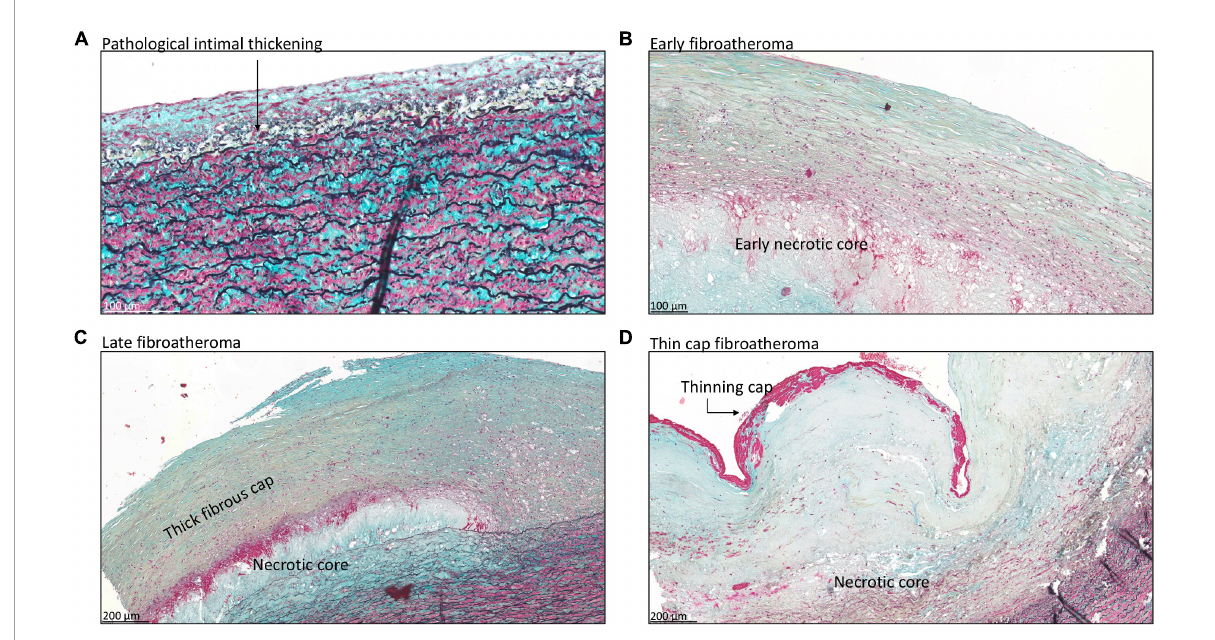
FIGURE3 Transverse histologic section (4 µ m) of type A aortic dissection aortic specimen, stained with MOVAT pentachrome. (A) Shows pathological intimal thickening, characterized by the presence of lipid pools deep within the intima near the intimal medial border with overlying vascular smooth muscle cells (black arrow). Fibroatheroma is seen in panels (B–D) , with an early necrotic core in panel (B) , thick fibrous cap in panel (C) , and thinning of the fibrous cap in panel (D) . Scale bar shown in the figures.